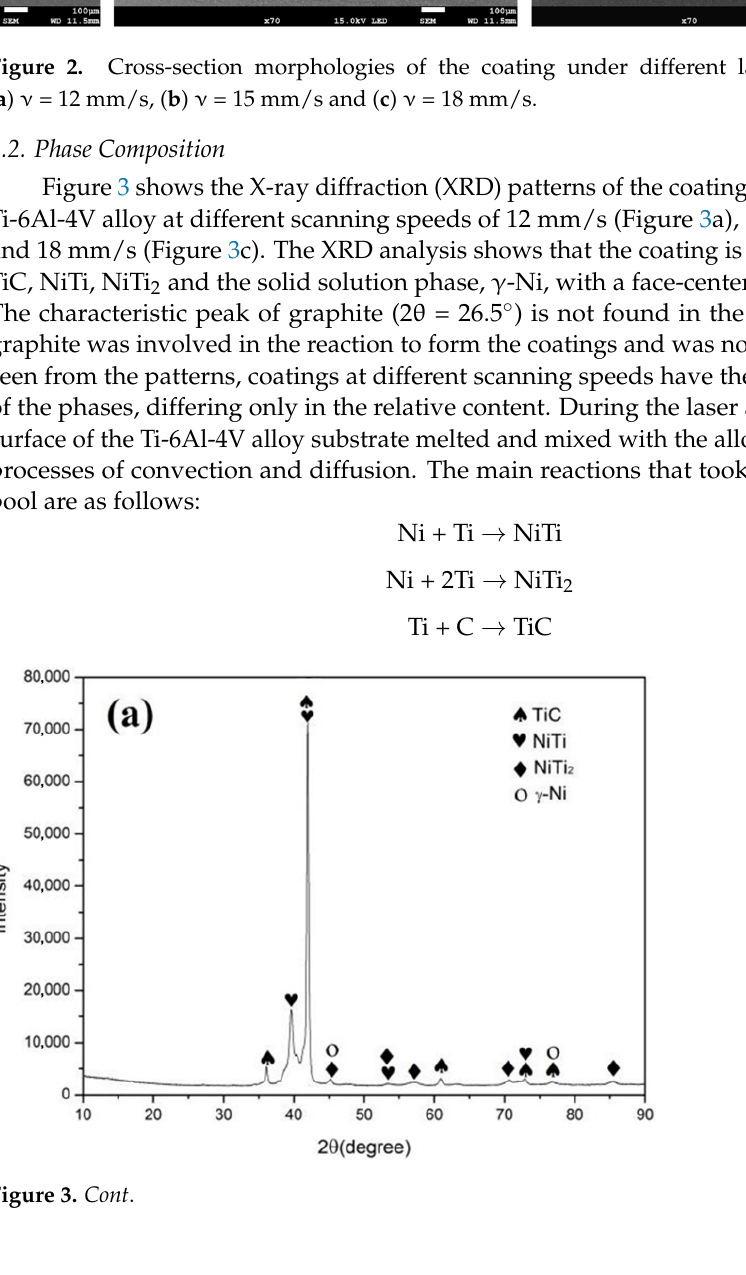
Figure 2. Cross-section morphologies of the coating under different laser scanning speeds: ( a ) ν = 12 mm/s, ( b ) ν = 15 mm/s and ( c ) ν = 18 mm/s.